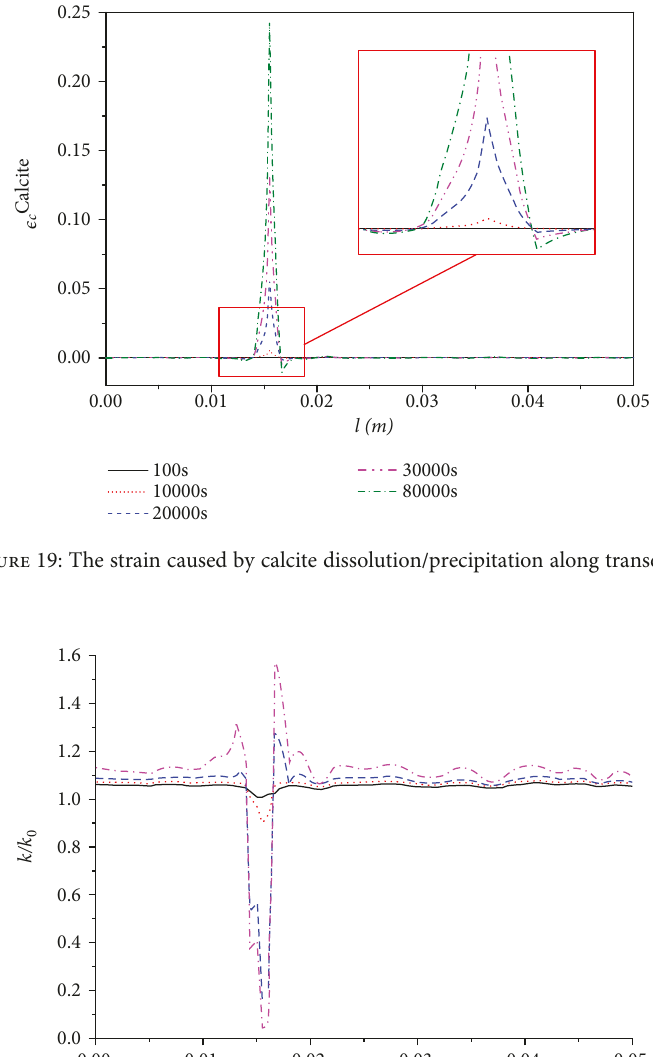
along transect 1 for di ff erent chemical activities ( t = 86000 0